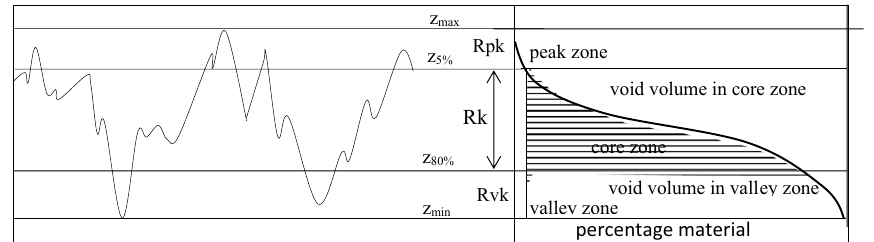
Fig. 3 Roughness parameter Rk (core of roughness) (μm)